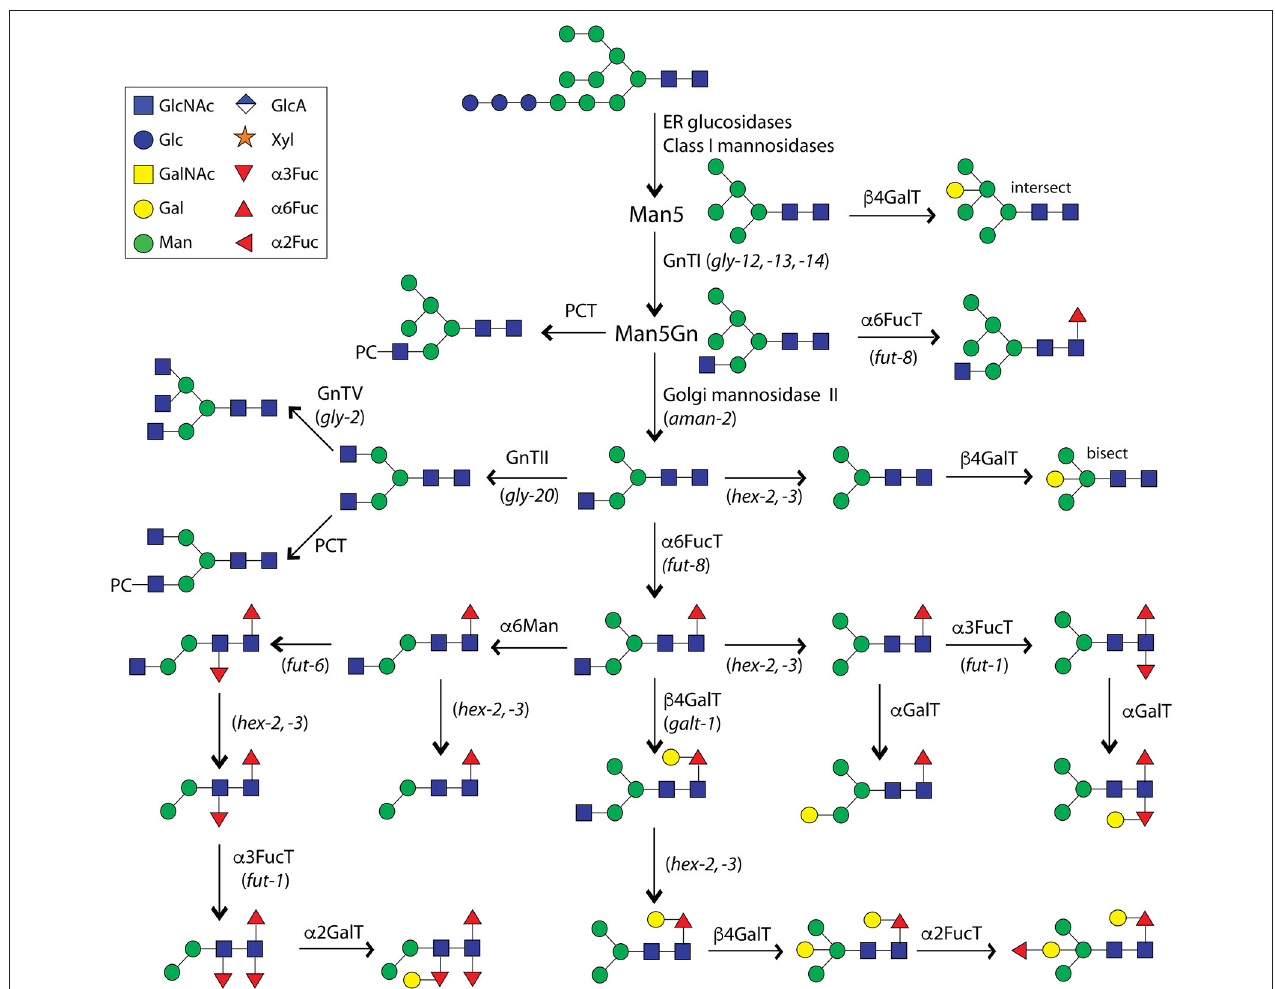
FIGURE 1 | Processing of N-glycans in C. elegans . This summary, which is an updated version of our 2008 figure (Paschinger et al., 2008), is not intended to be exhaustive, but shows a number of reactions proven in vitro or postulated to exist in vivo . Abbreviations for proven or potential enzymes are shown above/beside the arrows (FucT, fucosyltransferase; GalT, galactosyltransferase; GnT, N- acetylglucosaminyltransferase; Hex, hexosaminidase; Man, mannosidase; PCT, phosphorylcholinyltransferase), whereas names of genes (in italics) relevant for certain biosynthetic steps are indicated in brackets below/beside the arrows. The Symbolic Nomenclature for Glycans is used throughout this article (e.g., blue squares for GlcNAc, green circles for Man, yellow circles for Gal, and red triangles for Fuc residues; see also the top left